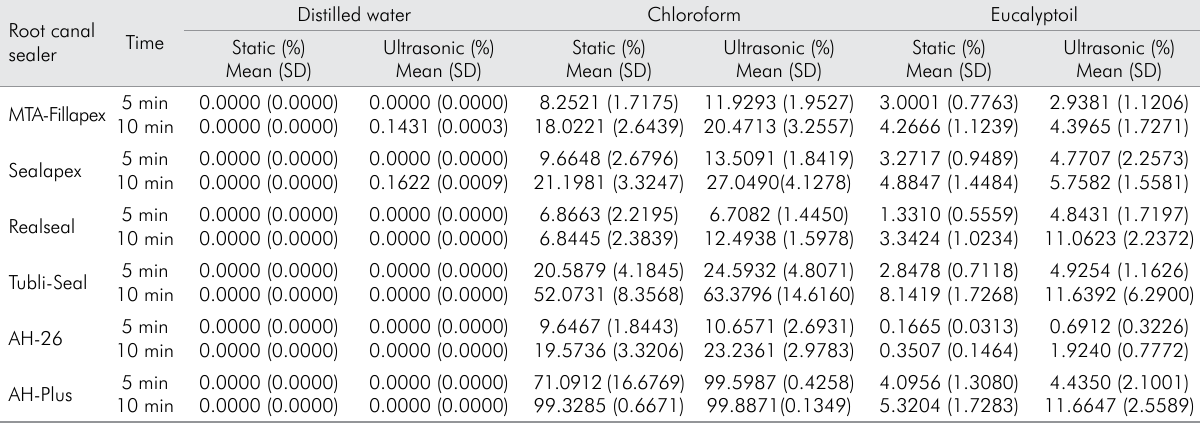
Table 2. Mean values and standard deviation (SD) of sealer dissolution in Distilled water, Chloroform, and Eucalyptoil in static and ultrasonic